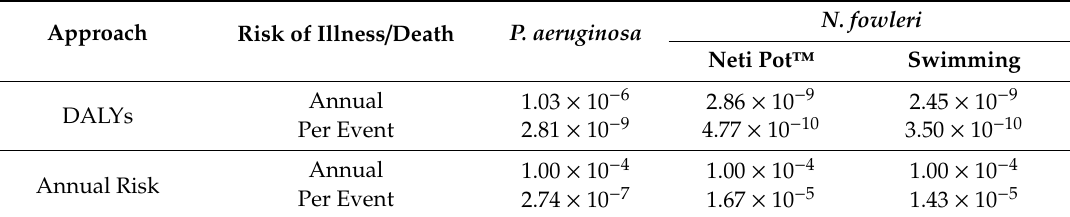
Table 5. Risk of illness / death based on DALYs and annual risk